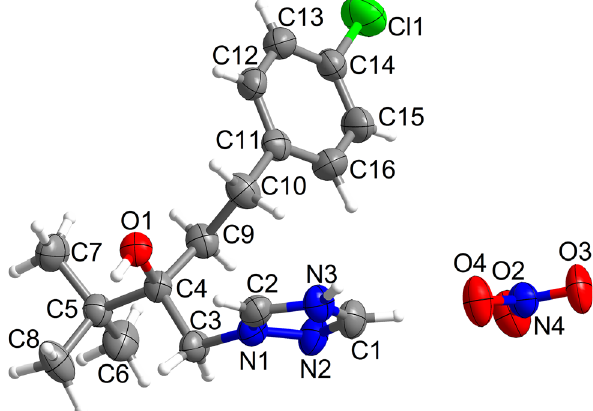
Table 1 contains crystallographic data and Table 2 contains the list of the atoms including atomic coordinates and displacement parameters.